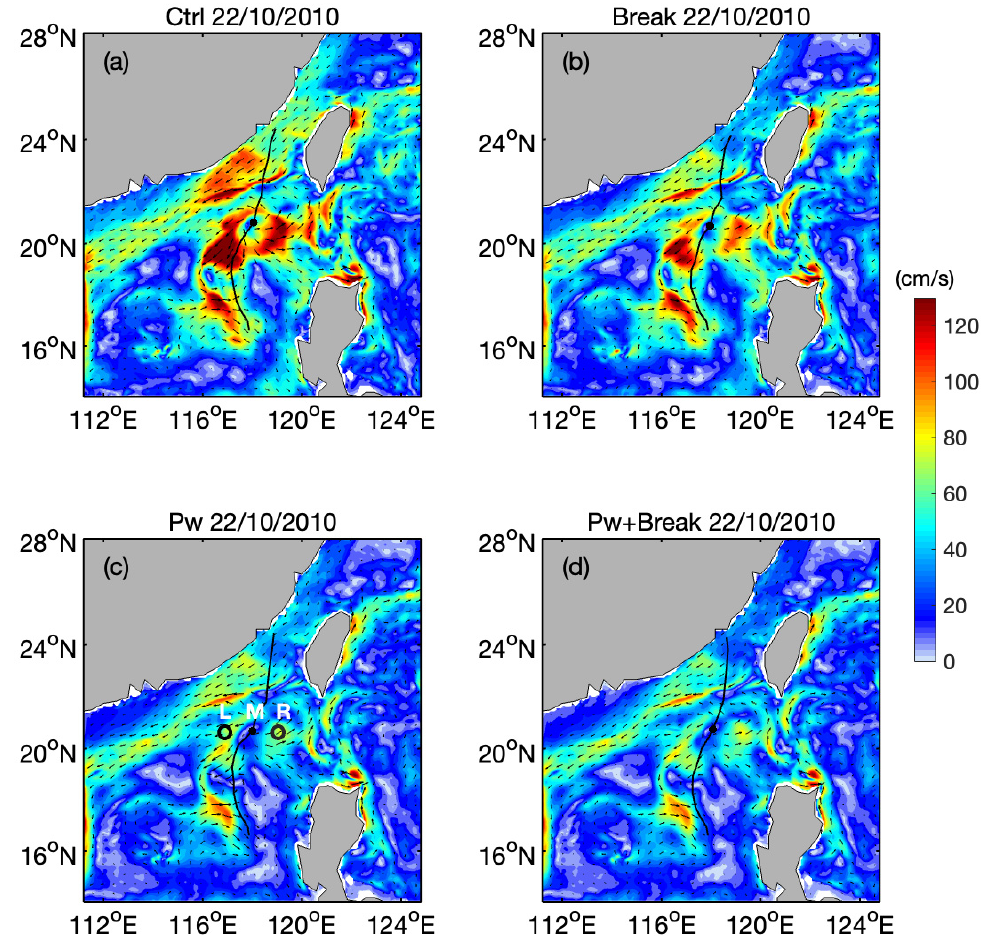
Figure 10. Sea surface currents (removed tides) simulated in different experiments at 00:00 UTC on 22 October 2010. The black dot in the panel ( c ) represents the typhoon center (M) at 00:00 UTC on 22 October. Two black circles in the panel ( c ) represent the locations of the right (R) and left (L) sides of Megi’s center (M).